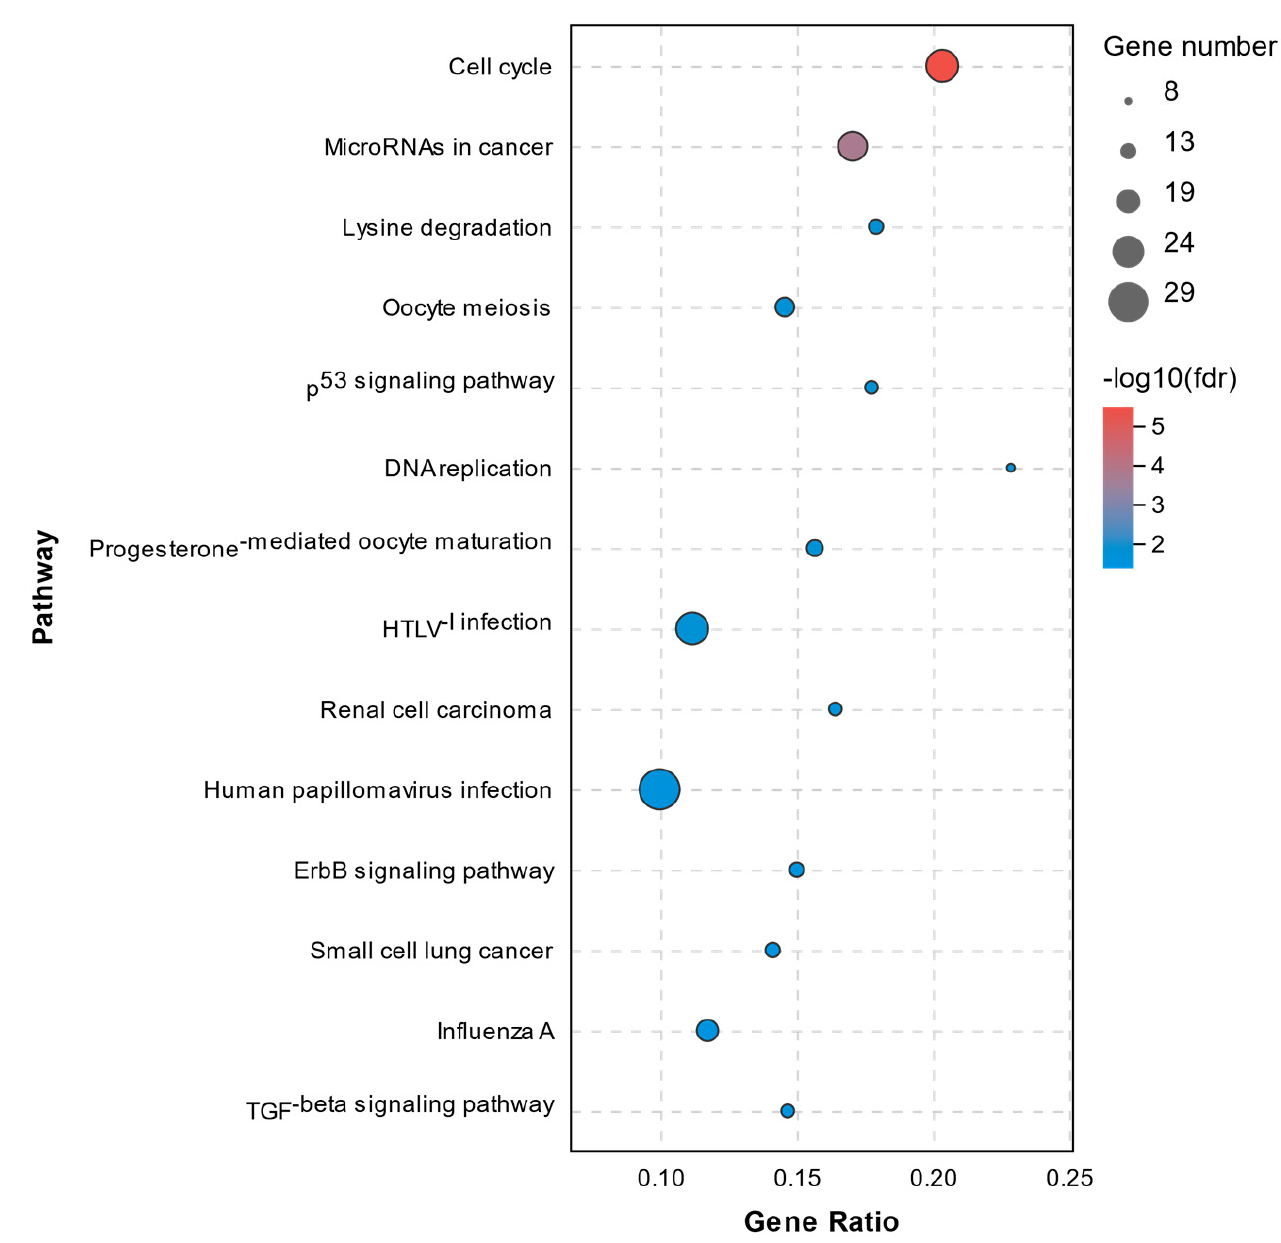
Figure 7. Top14 KEGG pathway analysis of DEGs between the C1 and C2 groups.